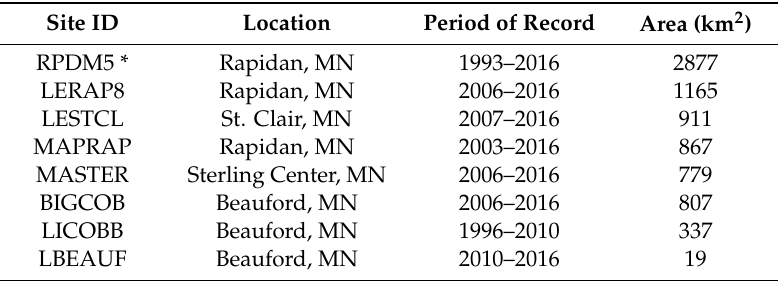
Table 2. Le Sueur River basin and subbasins gage sites. The outlet of Le Sueur River watershed, denoted with “*”, has United States Geological Survey station ID 05320500 and US National Weather Service ID RPDM5.